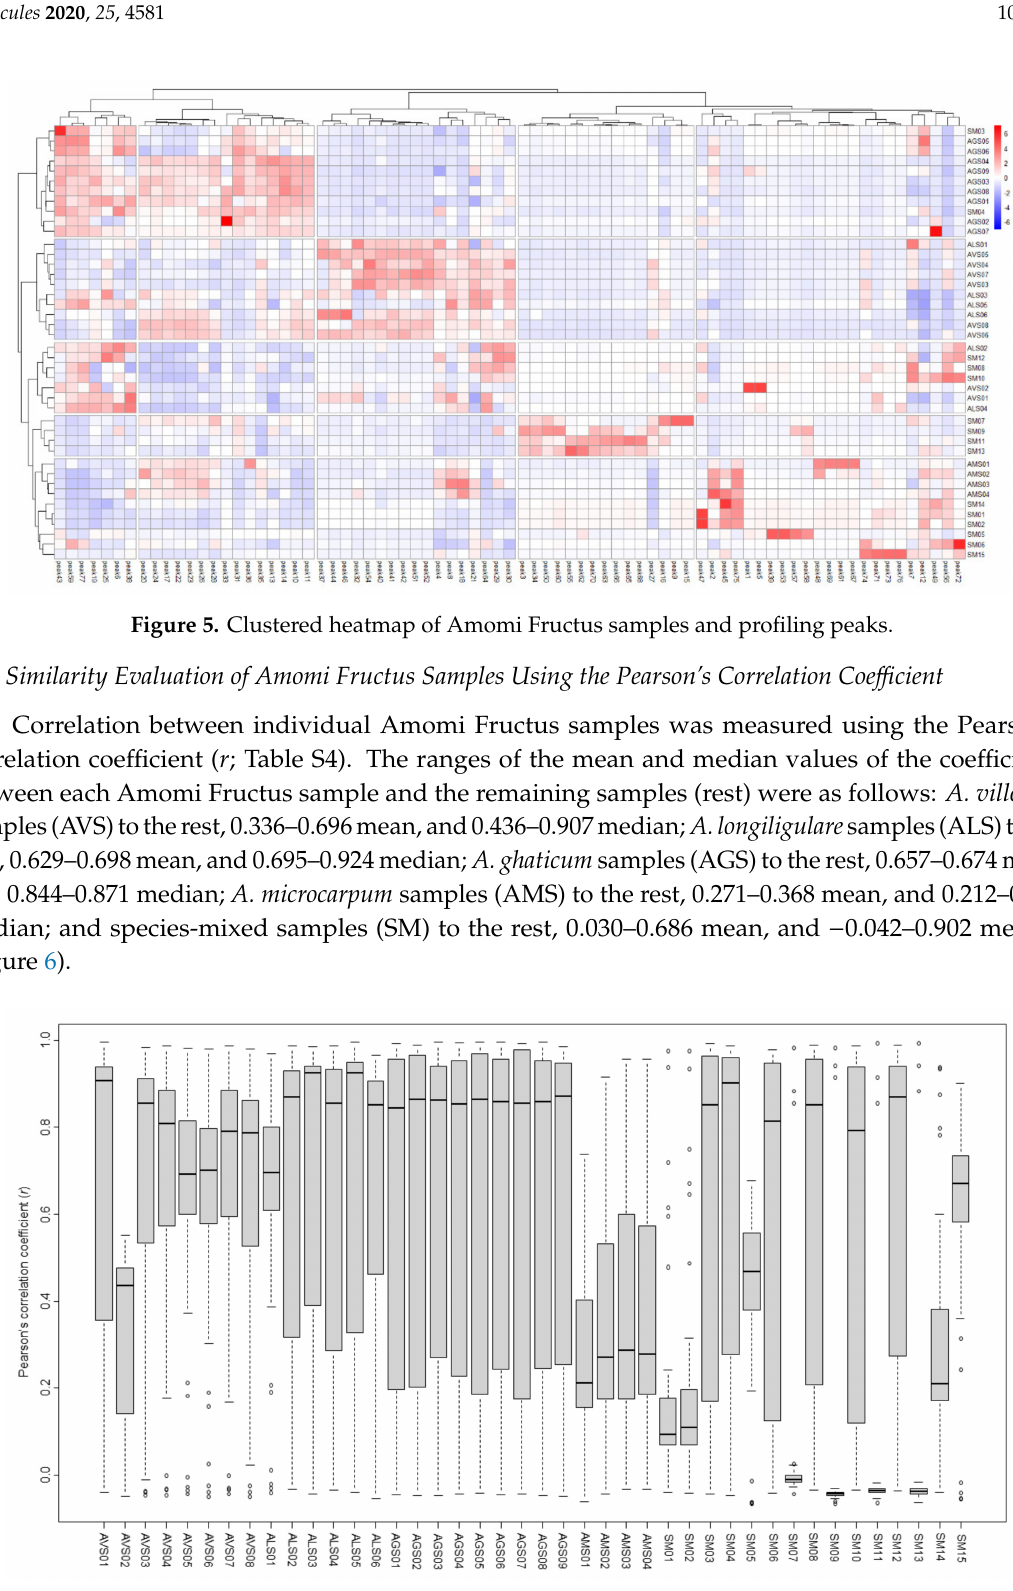
Figure 6. Average coe ffi cients of the Pearson’s correlation coe ffi cient of Amomi Fructus